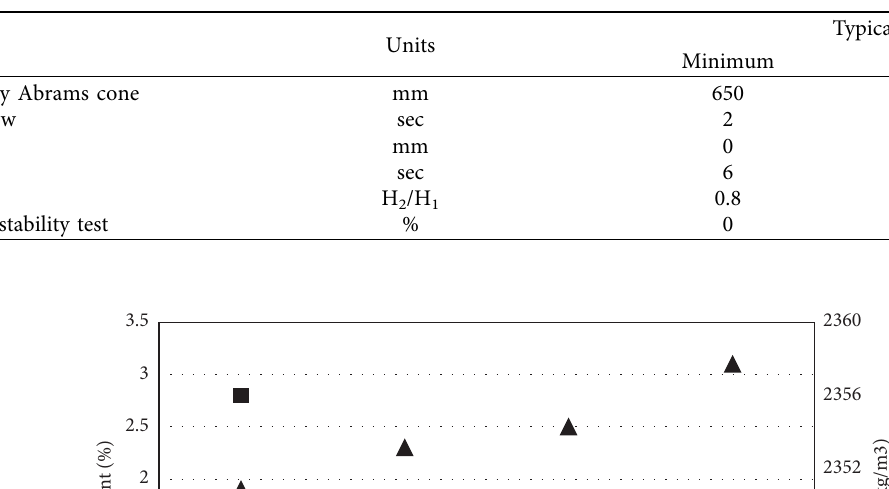
Table 6: Acceptance criteria for fresh properties of